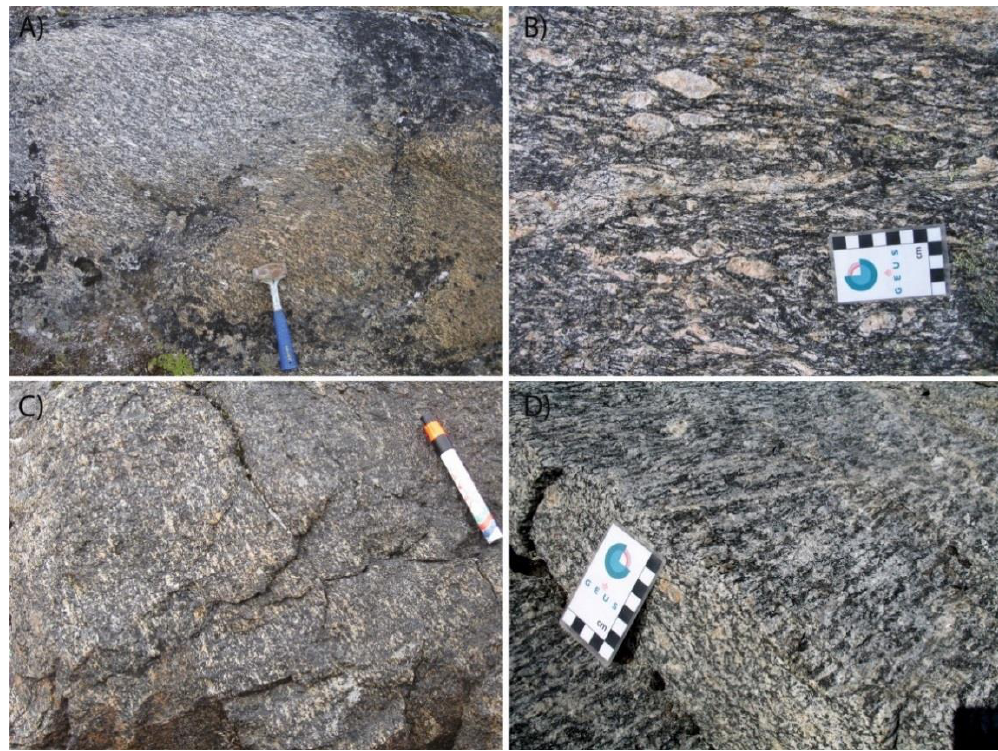
Figure 2. Field images illustrating characteristic textures from the Ilivertalik Intrusive Complex. ( A ) Out-crop relation between sample 484645 (upper left part of image) and sample 484644 lower right part of image) the brown alteration colour is characteristic of pyroxene bearing units. The sharp crosscutting the S-L textures in the granite, suggest that retrogression into amphibolite facies occurred after ductile deformation overprinting. ( B ) Characteristic feldspar clastic granite unit. ( C ) Texture of a dioritic unit (equivalent to sample 508204). ( D ) Lineated granodiorite (equivalent to sample 468689).